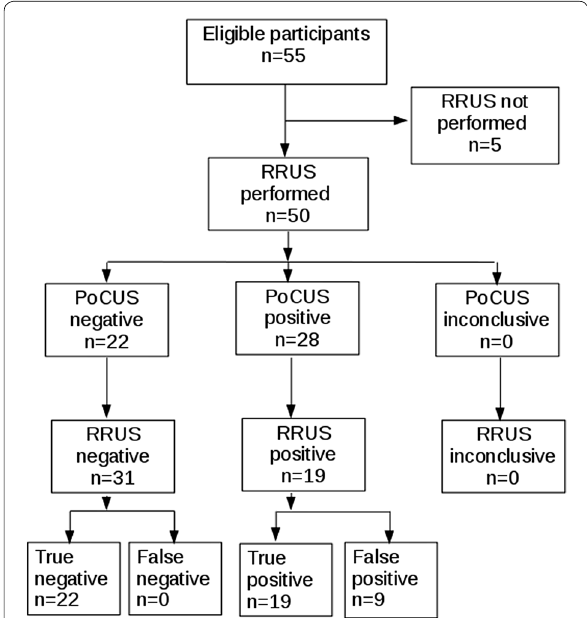
Fig. 1 STARD chart of patients included in a prospective study exploring PoCUS